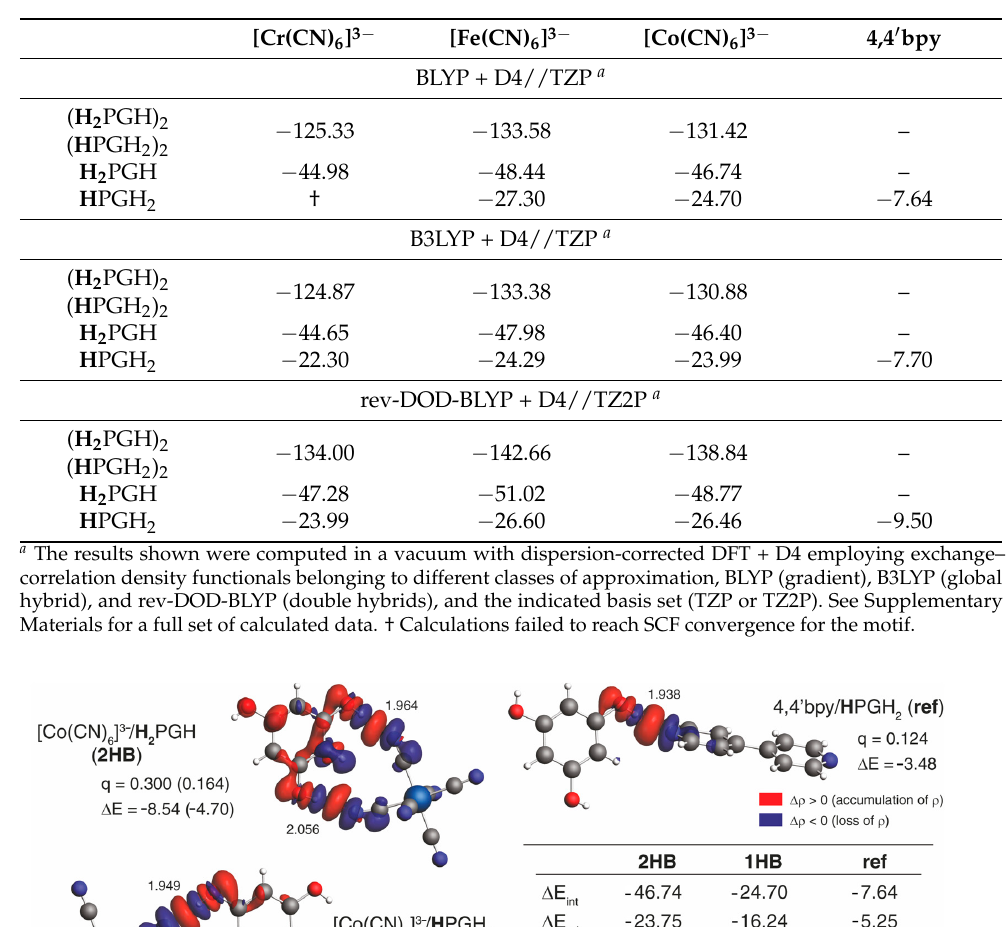
π -electron system within H 3 PG, enhanced likely due to ion–dipole interaction imposed by the negative charge of the [Co(CN) 6 ] 3 − . Such electron-transfer channels in {4,4 (cid:48) bpy; H PGH 2 } and {dpe; H PGH 2 } are visibly diminished, which seems to be directly responsible for a pronounced decrease in the magnitude of the orbital-interaction contribution (even for {dpe; H PGH 2 }, for which a shorter hydrogen-bond distance significantly strengthens its corresponding orbital component, see Figure S17). This decrease in ∆ E orb along with less stabilizing ∆ E elstat provides less counterbalance for the repulsive Pauli interaction and, accordingly, a significant drop in the absolute values of ∆ E int for {4,4 (cid:48) bpy; H PGH 2 } and {dpe; H PGH 2 } was observed. DFT-computed interaction energy ∆ E int values (in kcal mol − 1 ) between [M(CN) 6 ] 3 − (M = Cr, Fe, Co) anion and H 3 PG molecule(s) in molecular clusters {[M(CN) 6 ] 3 − ;( H 2 PGH) 2 ( H PGH 2 ) 2 }, {[M(CN) 6 ] 3 − ; H 2 PGH}, and {[M(CN) 6 ] 3 − ; H PGH 2 } extracted from the crystal structures of 1 , 2 , and 3 . For comparison, the corresponding interaction energies between 4,4 (cid:48) -bipyridyl (4,4 (cid:48) bpy) and H 3 PG in molecular cluster {4,4 (cid:48) bpy; H PGH 2 } extracted from the crystal structure reported in Ref. [64] are listed.